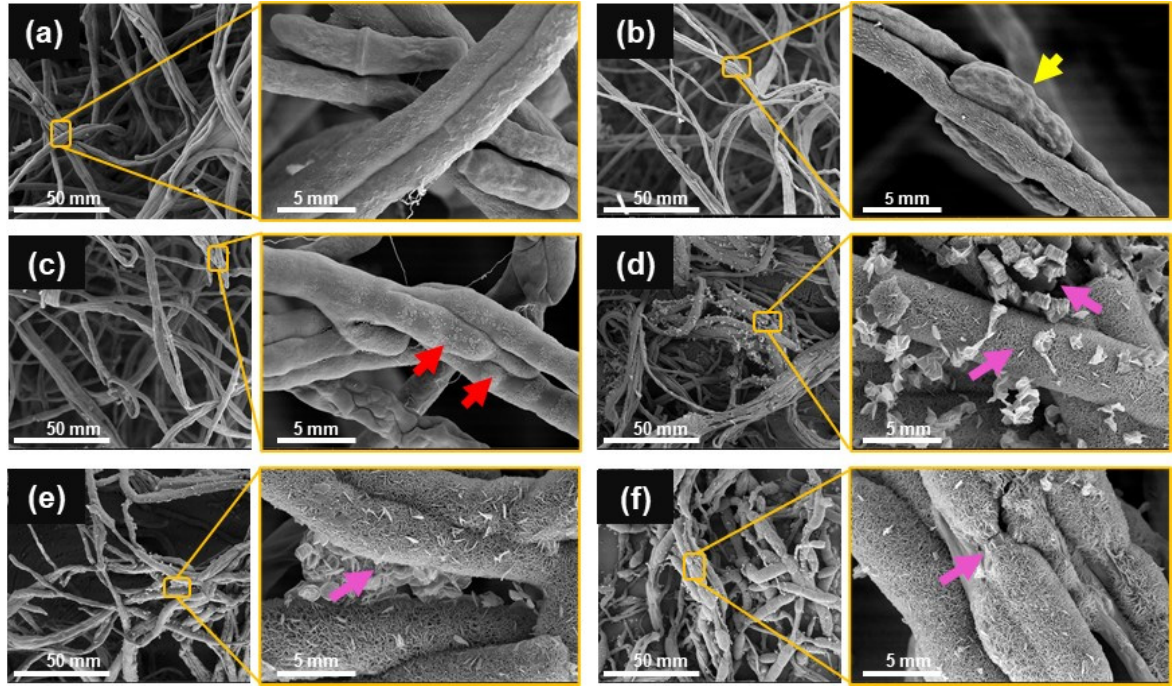
Figure 3. SEM micrographs of F. kuroshium hyphae after growing 6 days in PDA culture medium supplemented with different concentrations of Cu-NPs: ( a ) 0 (control), ( b ) 0.1, ( c ) 0.25, ( d ) 0.5, ( e ) 0.75, and ( f ) 1 mg/mL. The Cu-NPs treatments at concentrations as low as 0.1 mg/mL provoked changes in the hyphae morphology, ranging from an apparent loss of turgor to a loss of cell wall integrity. At 0.25 mg/mL, peeling hyphae (red arrow) indicated the loss of cell wall integrity. At concentrations of 0.5 mg/mL or greater, the hyphae cell wall showed higher porosity and leakage of the cytoplasmic contents (pink arrows). The yellow arrow indicates the morphological changes observed in the macroconidia, only found in the control and the 0.1 mg/mL treatment.